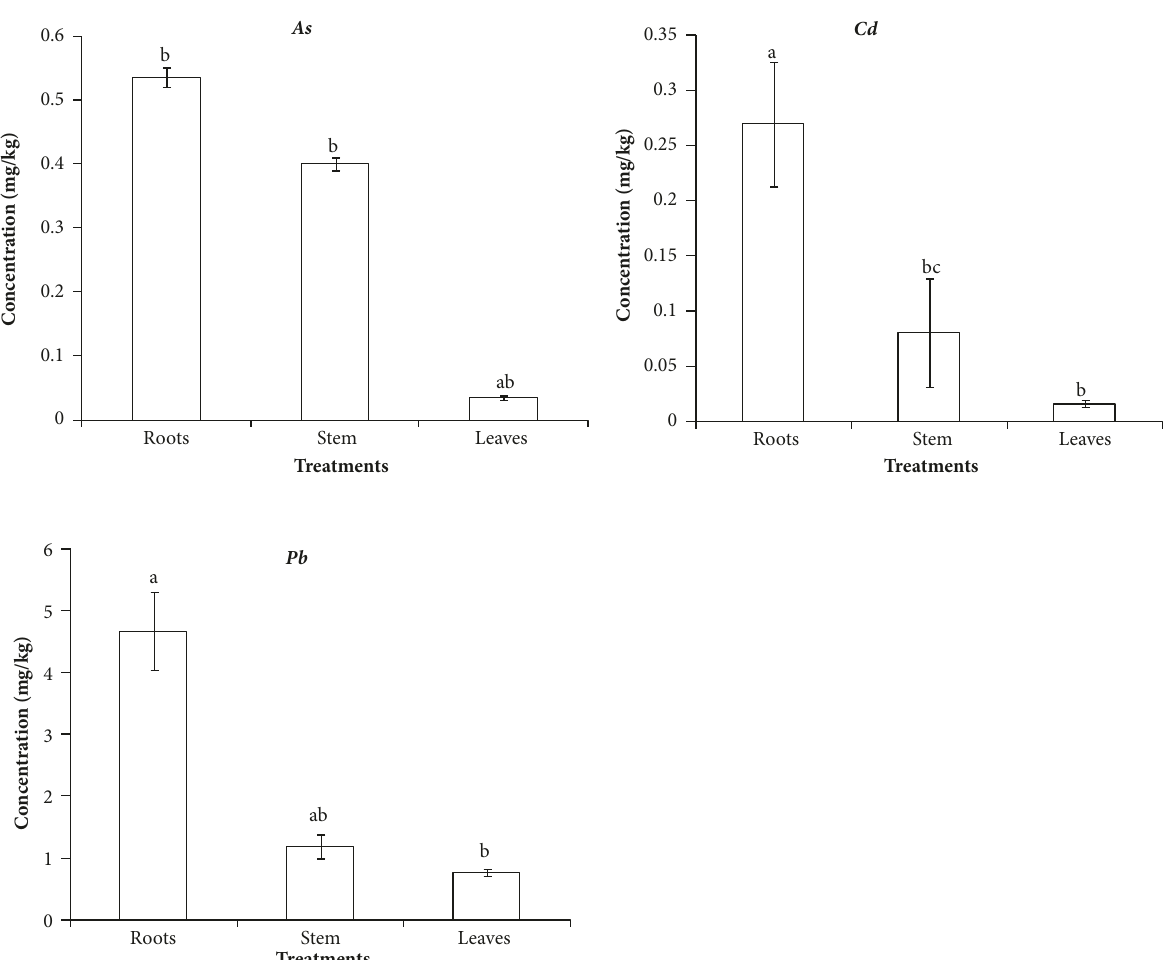
Figure 3: As , Cd, and Pb concentration level in roots, stem, and leaves. Different superscripts indicate significant difference (p < 0.05); similar superscripts indicate no significant difference (p > 0.05). ∗ SE: standard